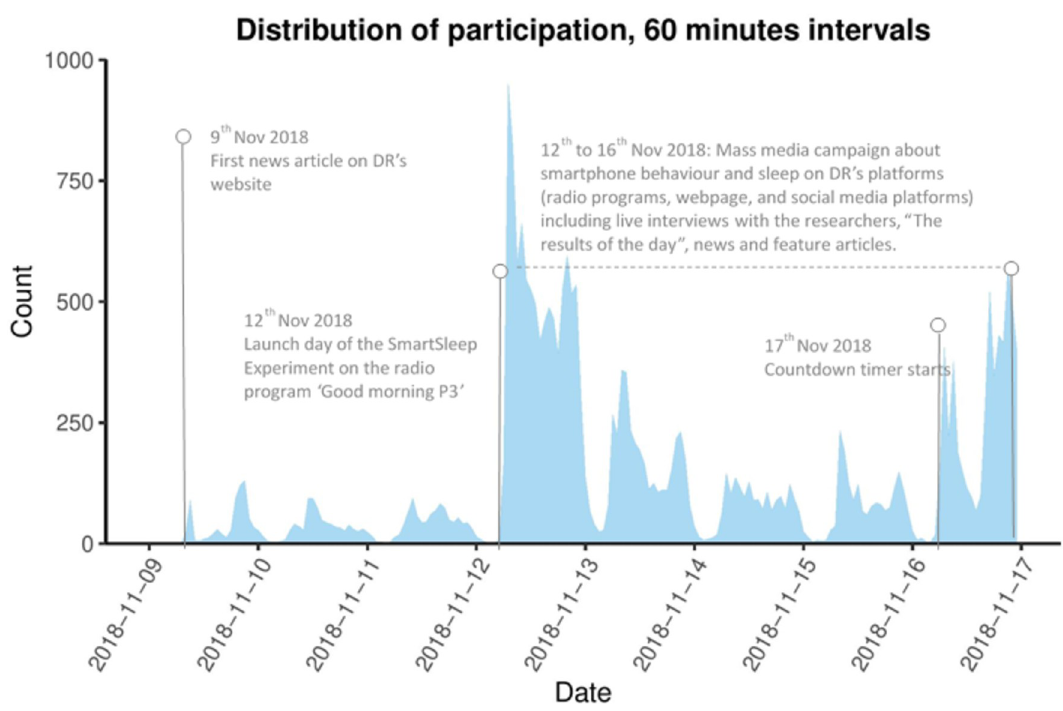
Fig 1. Distribution of participation during the week of the SmartSleep Experiment among 25,135